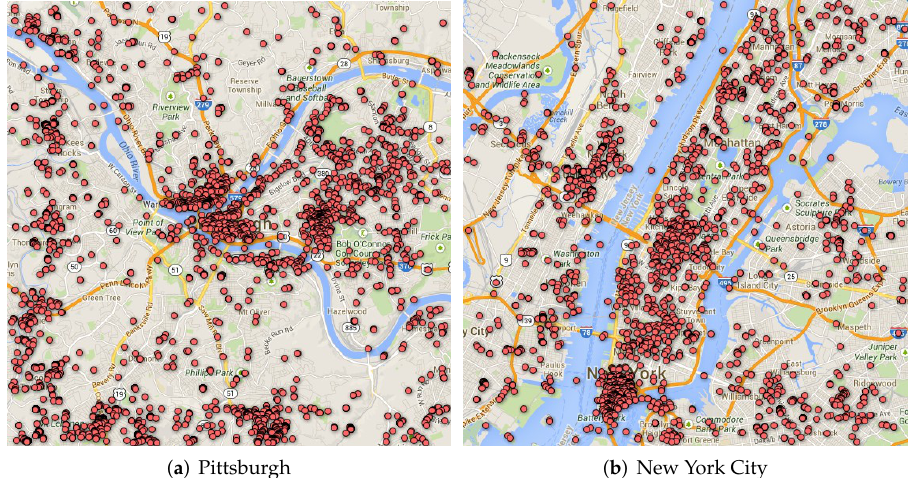
Figure 2. Distribution of geo-tagged tweets in different areas of the two cities, Pittsburgh ( a ) and New York City ( b ). The maps come from Google Maps with a zoom level of 10, and a scale ratio of 1:288895 given that Vector tile layers are used. For the map orientation, the north arrow follows naturally with the bottom-up direction in the figure. Each square image represents a 10 miles by 10 miles geographical region.